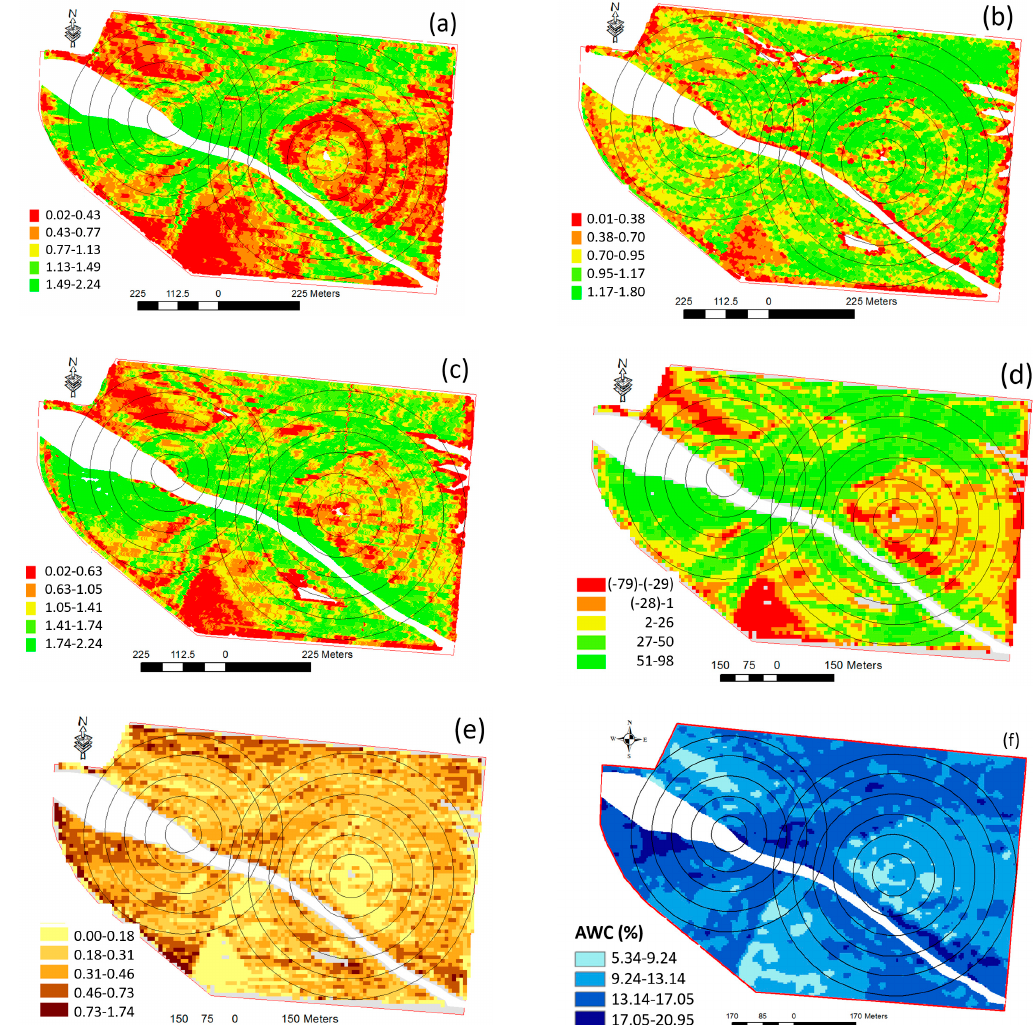
Figure 9. The cotton lint yield map (Mg ha − 1 ) time series from 2012 to 2014 ( a – c ), plus mean (( d ), using Equation (5)) and standard deviation cotton yield maps (( e ), using Equation (6)) that were derived from the producer’s harvester data (Table 3, seven years of data for cotton, corn and soybean) for a 73-ha field in west Tennessee. The map of plant available water content ( f ) within the crop effective root zone (i.e., 100 cm) is adapted from the study by [18].